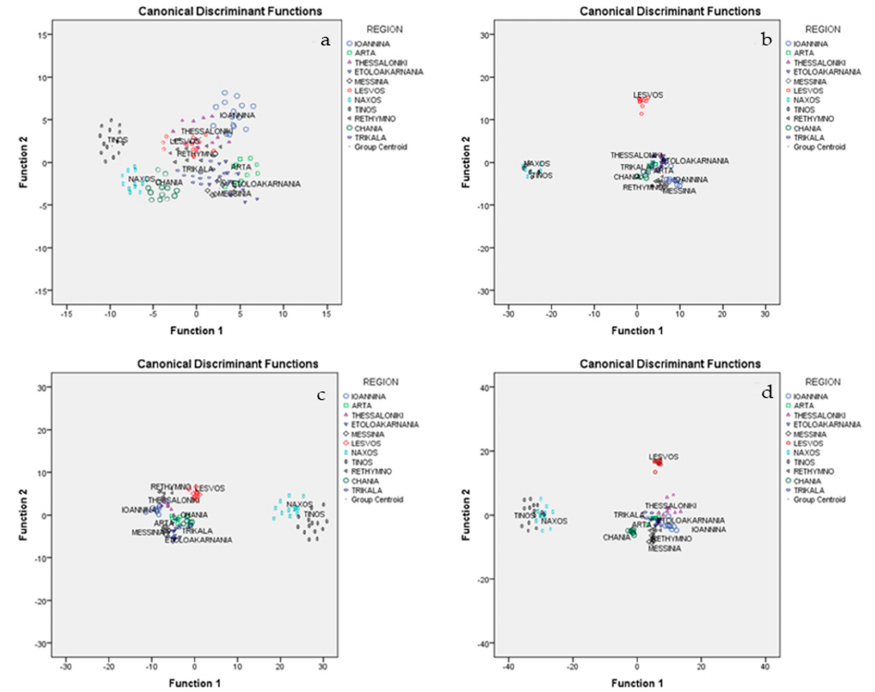
Figure 3. Geographical differentiation of graviera cheese from eleven regions based on the combinations of ( a ) minerals and conventional quality parameters (CQPs); ( b ) FA composition and minerals; ( c ) FA composition and CQPs; and ( d ) FA composition, minerals, and CQPs.